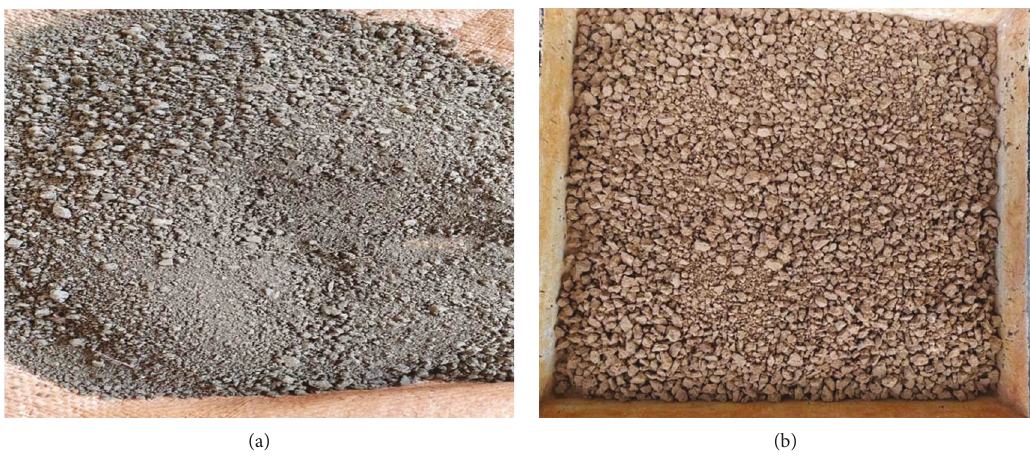
Figure 1: Soil sample: (a) air dried and (b) kilned/burned.